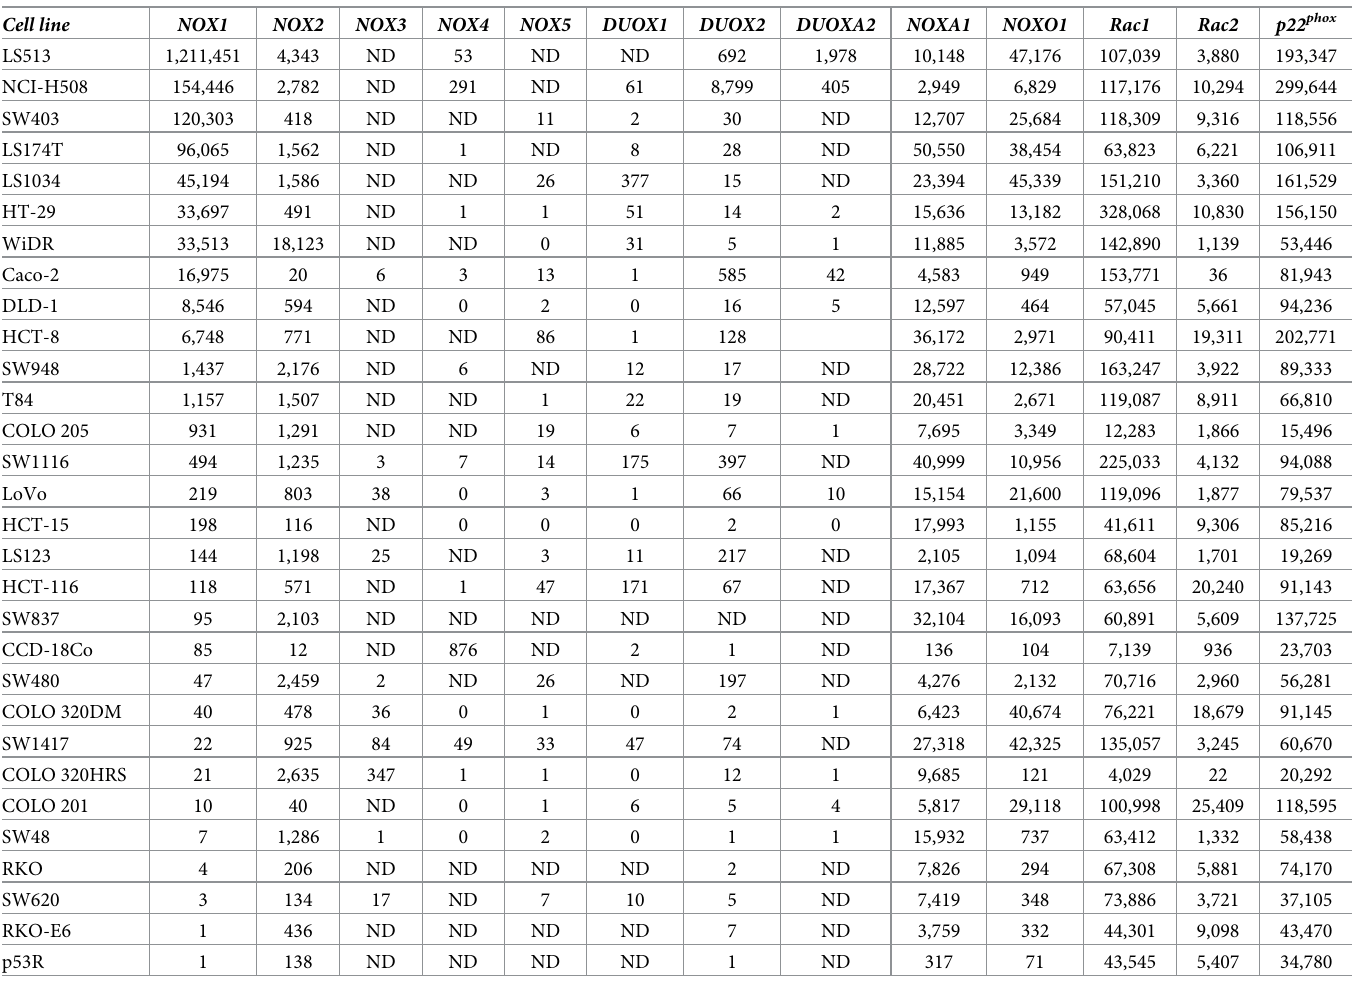
Table 1. Expression of NOX isoforms and accessory molecules in human colorectal cancer cell